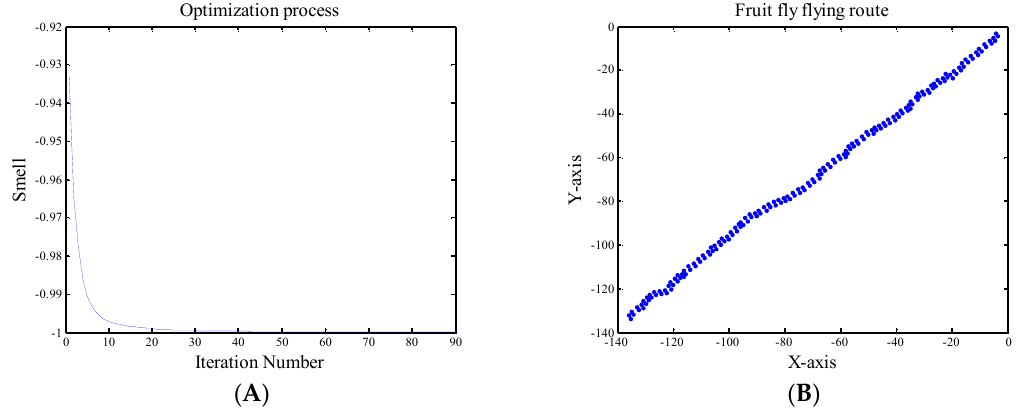
Figure 7. ( A ) Optimization process of FOA; and ( B ) fruit fly flying route of FOA.